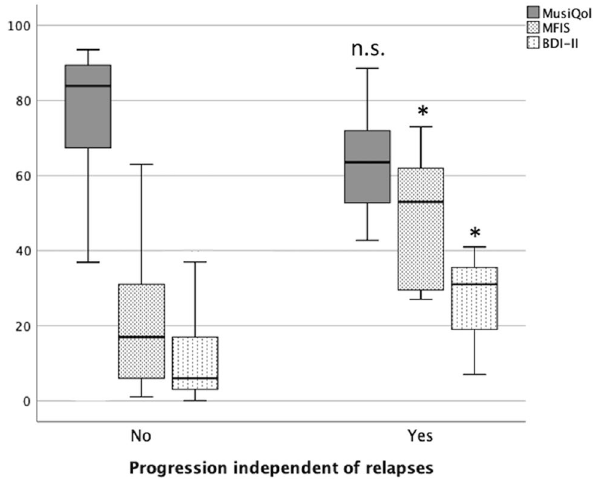
Figure 2. Association between progression independent of relapse (PIRA) and baseline PROs results. Box plot showing PRO results in patients that experienced progression-independent of relapse disability (PIRA) compared to those that did not at the end of the study period (2-year). Although all scales worsened in patients with PIRA, MFIS and BDI-II scales were significantly higher in these patients. Abbreviations: PRO: patient- reported outcomes; MusiQoL: Multiple Sclerosis Quality of Life; MFIS: Modified Fatigue Impact Scale; BDI-II: Beck Depression Inventory-II; PIRA: progression-independent of relapse